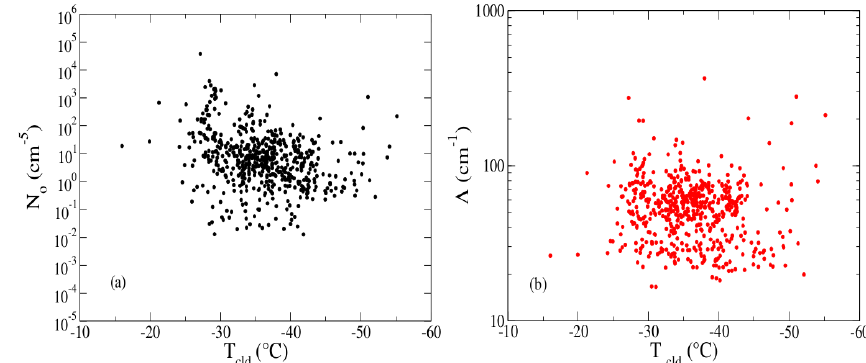
Figure 15. (a, b) Intercept N o and slope (cid:51) as a function of the cloud retrieved temperature ( T cld ).